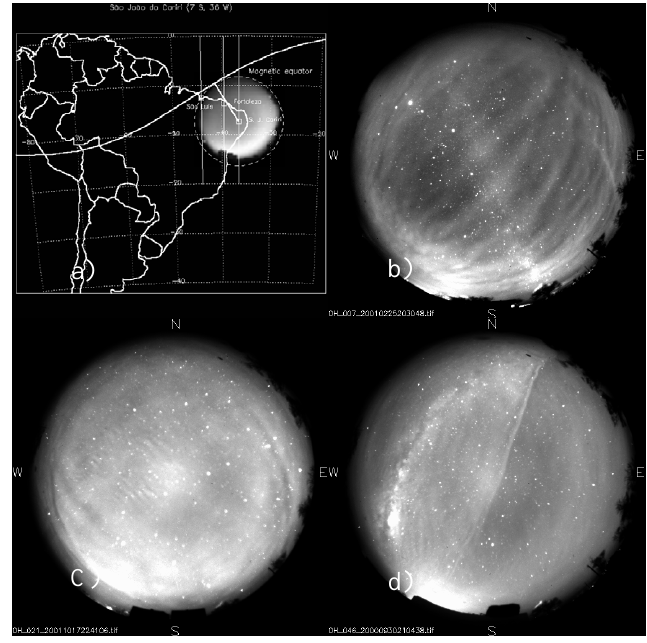
Fig. 1 – Observation site map (a) and gravity waves imaged during observation period. Fig. 1. Observation site map (a) and gravity waves imaged during observation period. Band (b) , ripple (c) and bore (d) . Band (b), ripple (c) and bore (d). Events total number/observation hours for all years